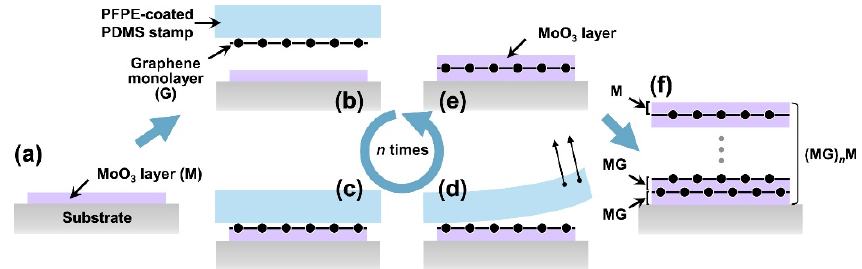
Figure 8. Schematic of the fabrication of MoO 3 -interlayer-doped graphene multilayers [47]. Thermally deposited a MoO 3 layer on a substrate ( a ). A graphene monolayer deposited on a PFPE-coated PDMS stamp by a modified wet-transfer method is transferred onto the MoO 3 layer by a transfer- printing process [( b – d )]. Next, another MoO 3 layer is deposited on the transfer-printed graphene layer ( e ). By performing steps ( b ) through ( e ) n times, (MG)nM is obtained ( f ).